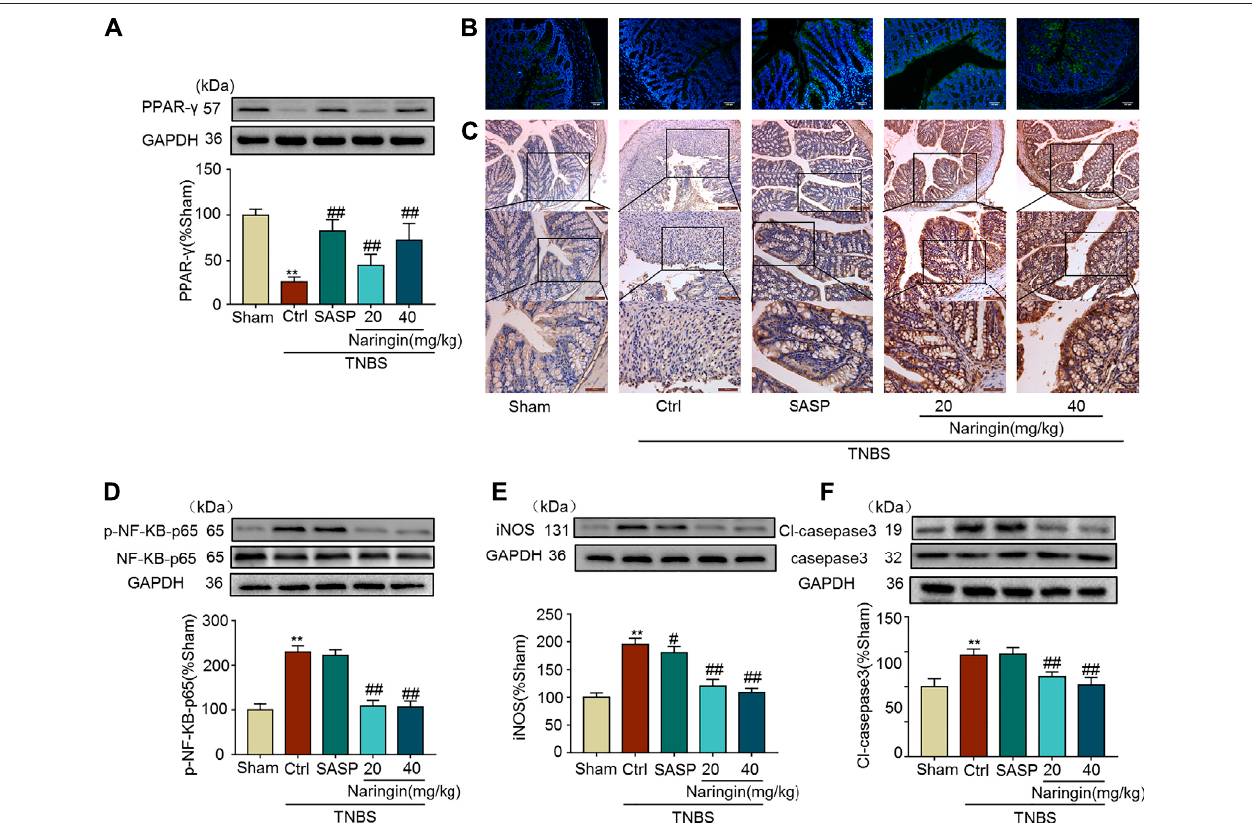
FIGURE 11 | Effects of naringin on PPAR- γ expression, in fl ammation and apoptosis in TNBS-colitis mouse model. (A) Western blotting analysis of PPAR- γ . (B) IF staining of PPAR- γ in colonic epithelium. Scale bars, 100 μ m. (C) IHC staining of PPAR- γ in colonic epithelium. Scale bars, 200, 100, and 50 μ m. Western blotting analysisofin fl ammation-related proteins (D) p-NF- κ B-p65(calculated asp-NF- κ B-p65/ NF- κ B-p65), (E) iNOS; apoptosis-relatedprotein (F) cl-caspase3,calculatedas cl-caspase3/caspase3.Dataareexpressedasmean ± SD.Valuesintheshamgrouparesetto100%andothervaluesaregivenrelativetothoseintheshamgroup. ** p < 0.01comparedwithsham group; # p < 0.05, ## p < 0.01 compared withTNBS-colitisgroup; n (cid:2) 3samplesin western blottingexperiments; n (cid:2) 6samplesforother experiments. These blots are cropped, and the full-length blots are presented is in the Supplementary Figures S22 – S31